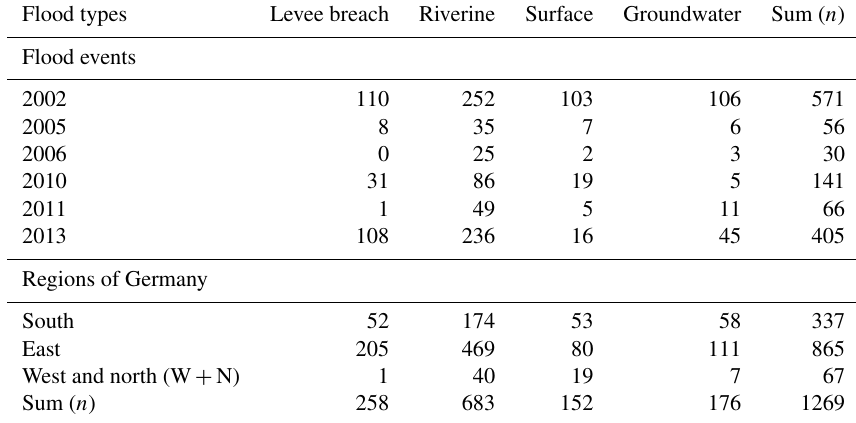
Table 2. Number of instances in the training set used across grouping variables flood type, region, and event year ( n =